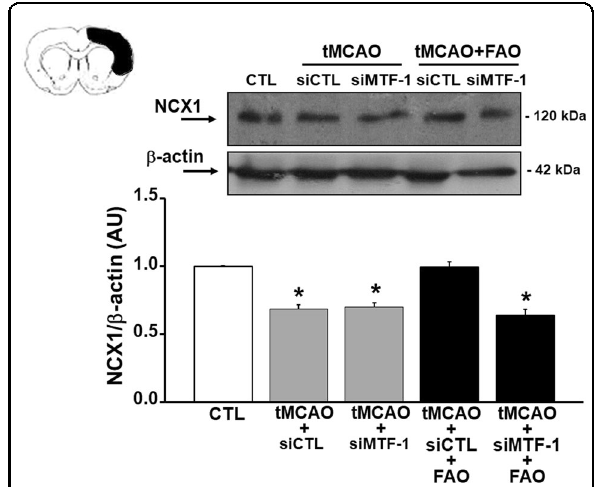
Fig. 5 Knocking down MTF-1 by siRNA strategy reverted RLIP- induced upregulation of NCX1. Representative Western blot of NCX1 in the cortex of rat: (i) sham-operated (CTL), (ii) exposed to tMCAO and icv-injected with a non targeting siRNA (tMCAO + siCTL) or a siRNA for MTF-1 (tMCAO + siMTF-1) and; (iii) to tMCAO + FAO icv- injected with a non targeting siRNA (tMCAO + siCTL + FAO) or a siRNA for MTF-1 (tMCAO + siMTF-1 + FAO). * p < 0.05 vs. CTL by one-way ANOVA followed by Bonferroni test. Each column represents the mean ± SEM ( n = 4/5).